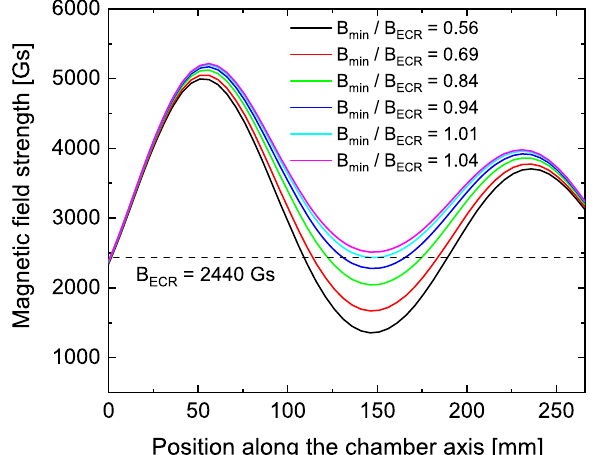
FIG. 3. Magnetic field profile along the plasma chamber axis when increasing the B